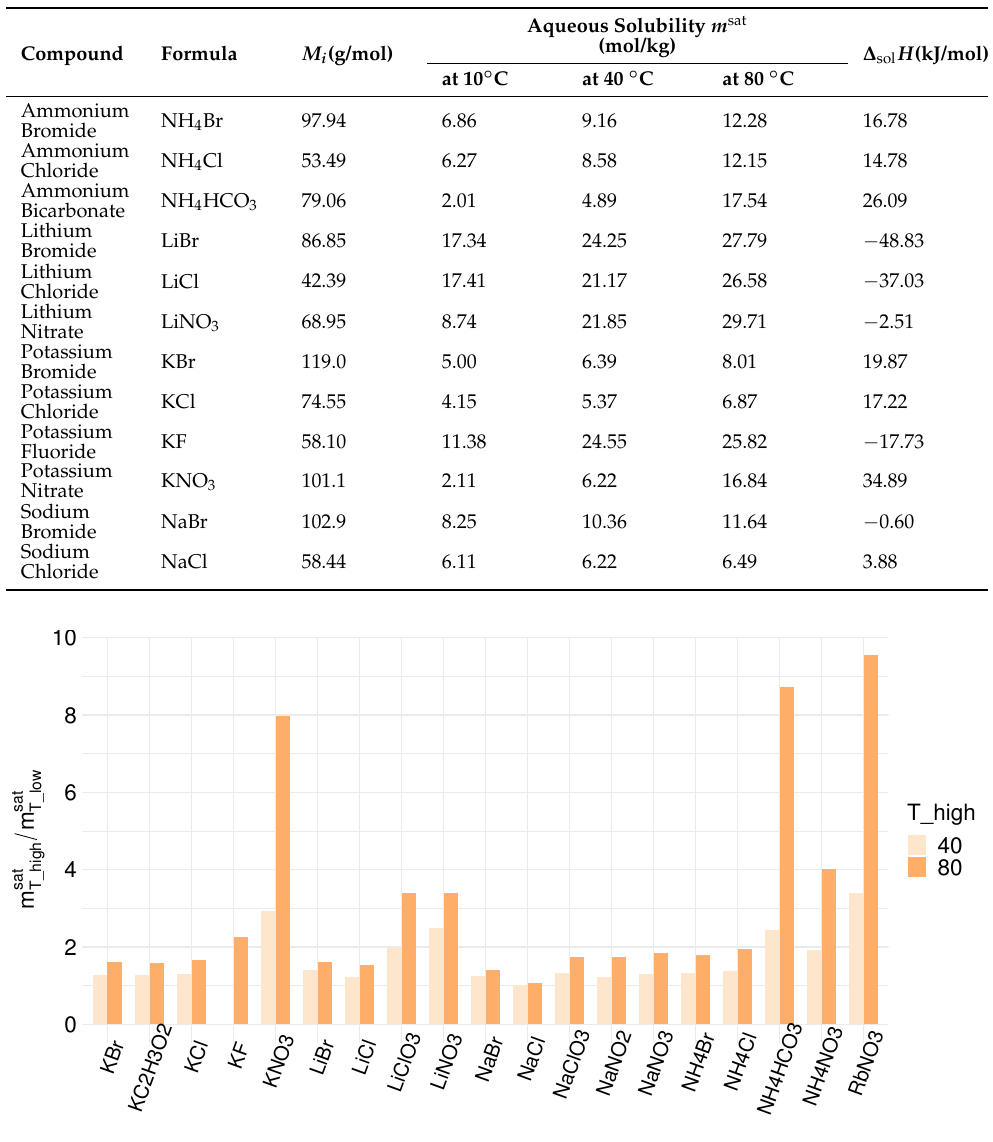
Table 4. Potential electrolytes for the use in REDHE with saturation concentrations in water at T = 10 °C, T = 40 °C, and T = 80 °C, and molar enthalpies of solution at infinite dilution (assumed constant in temperature range) [132].